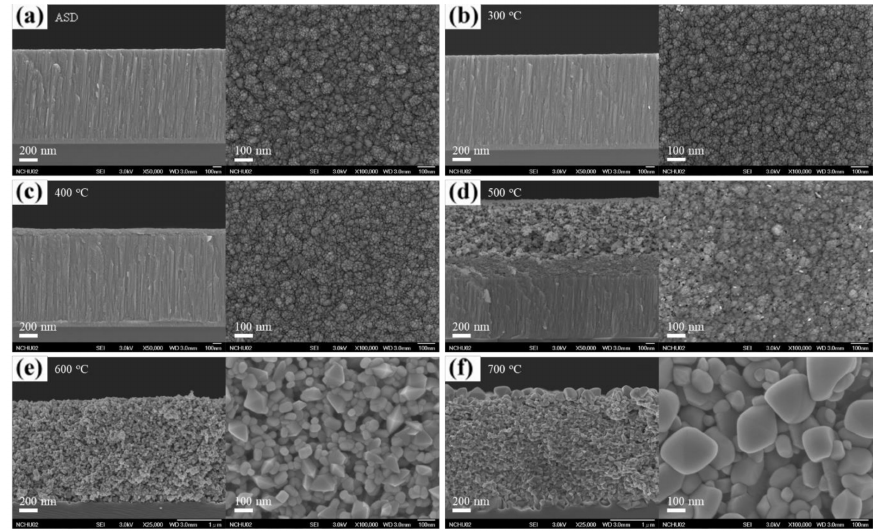
Figure 3. Plan-view and cross-sectional SEM micrographs of the (CrTaTiVZr)N coatings after annealing at di ff erent temperatures in air. ( a ) as-deposited, ( b ) 300 ◦ C, ( c ) 400 ◦ C, ( d ) 500 ◦ C, ( e ) 600 ◦ C, ( f ) 700 ◦